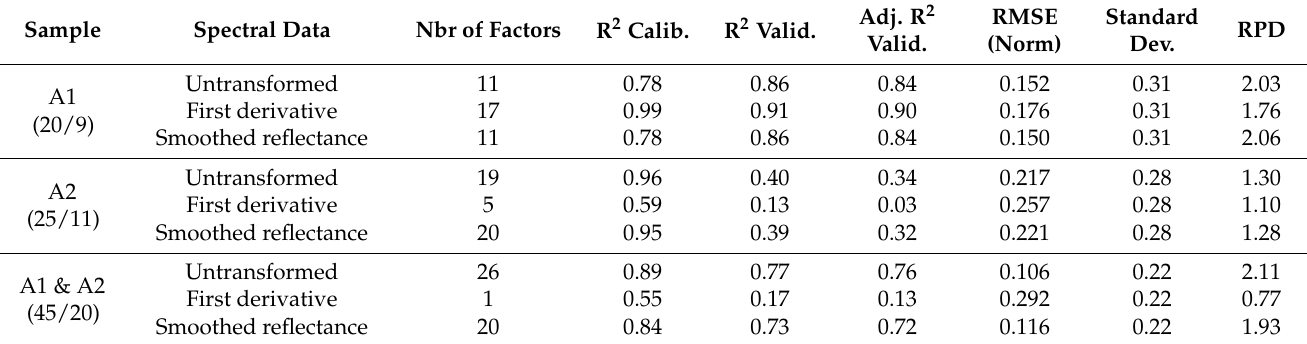
Table 3. Validation results of the PCR models for estimating SOC using the 350–2500 nm